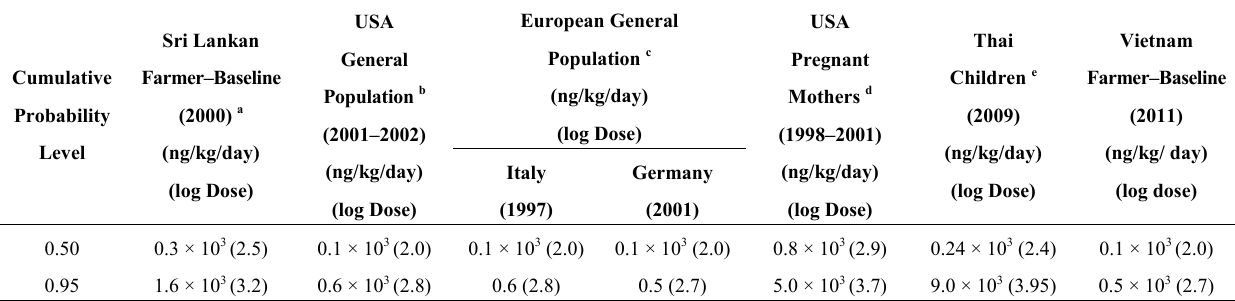
Table 5. Equivalent Chlorpyrifos Ingested Doses (ECID) in General and Some Specific Population